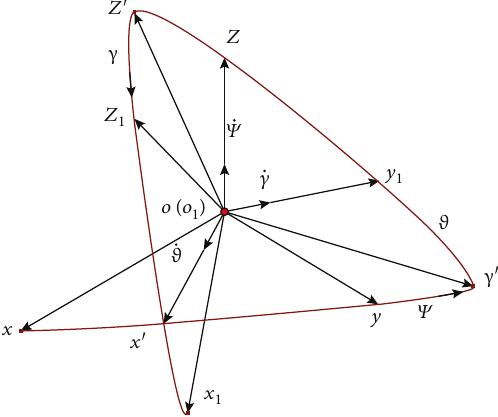
Figure 2: Schematic diagram of the attitude coordinate of the missile coordinate